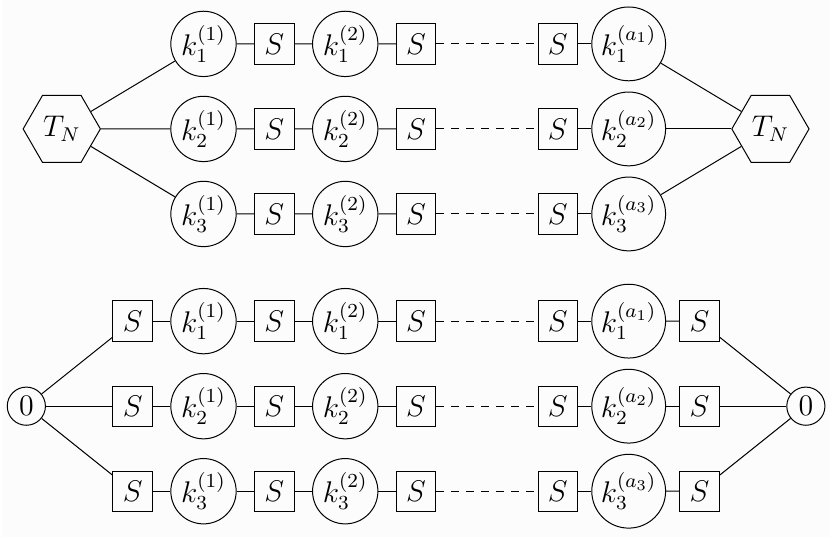
Figure 12 . The 3d theory associated to the 3-manifold given in figure 11. The second one is obtained by applying the 3d mirror symmetries to the two T